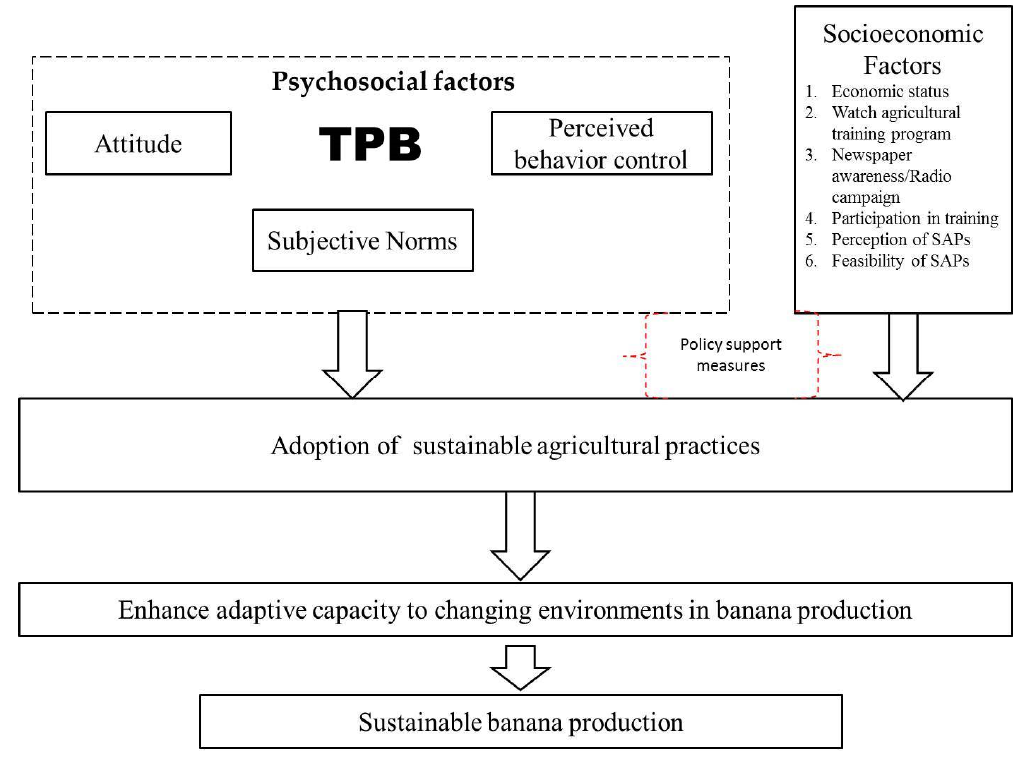
Figure 2. Conceptual